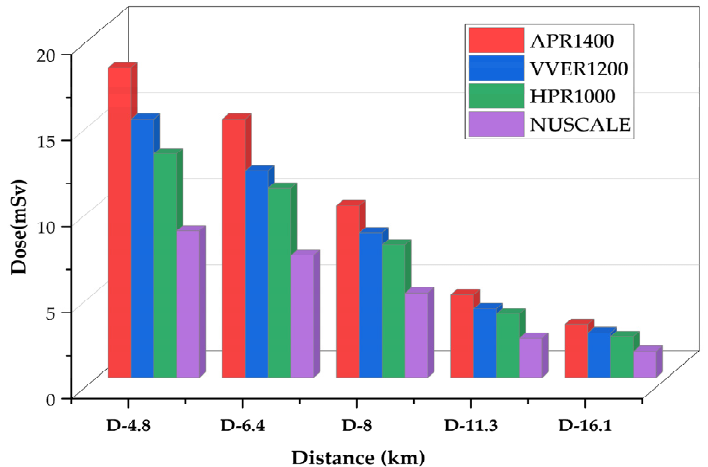
Figure 9. Graph of TEDE comparison during long-term station blackout within 16 km for APR1400, VVER1200, HPR1000, and Nuscale Power Module.